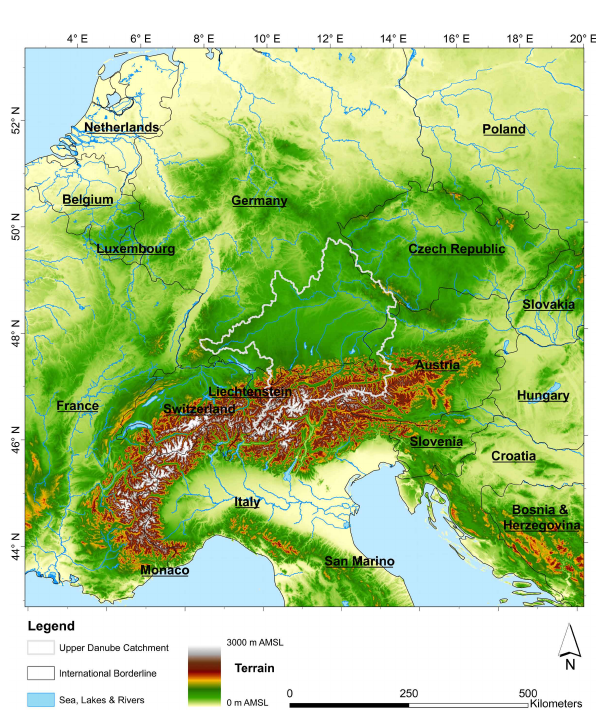
Fig. 2. Topography (based on SRTM data) of the area of interest, showing the European countries as well as the boundaries of the Upper Danube